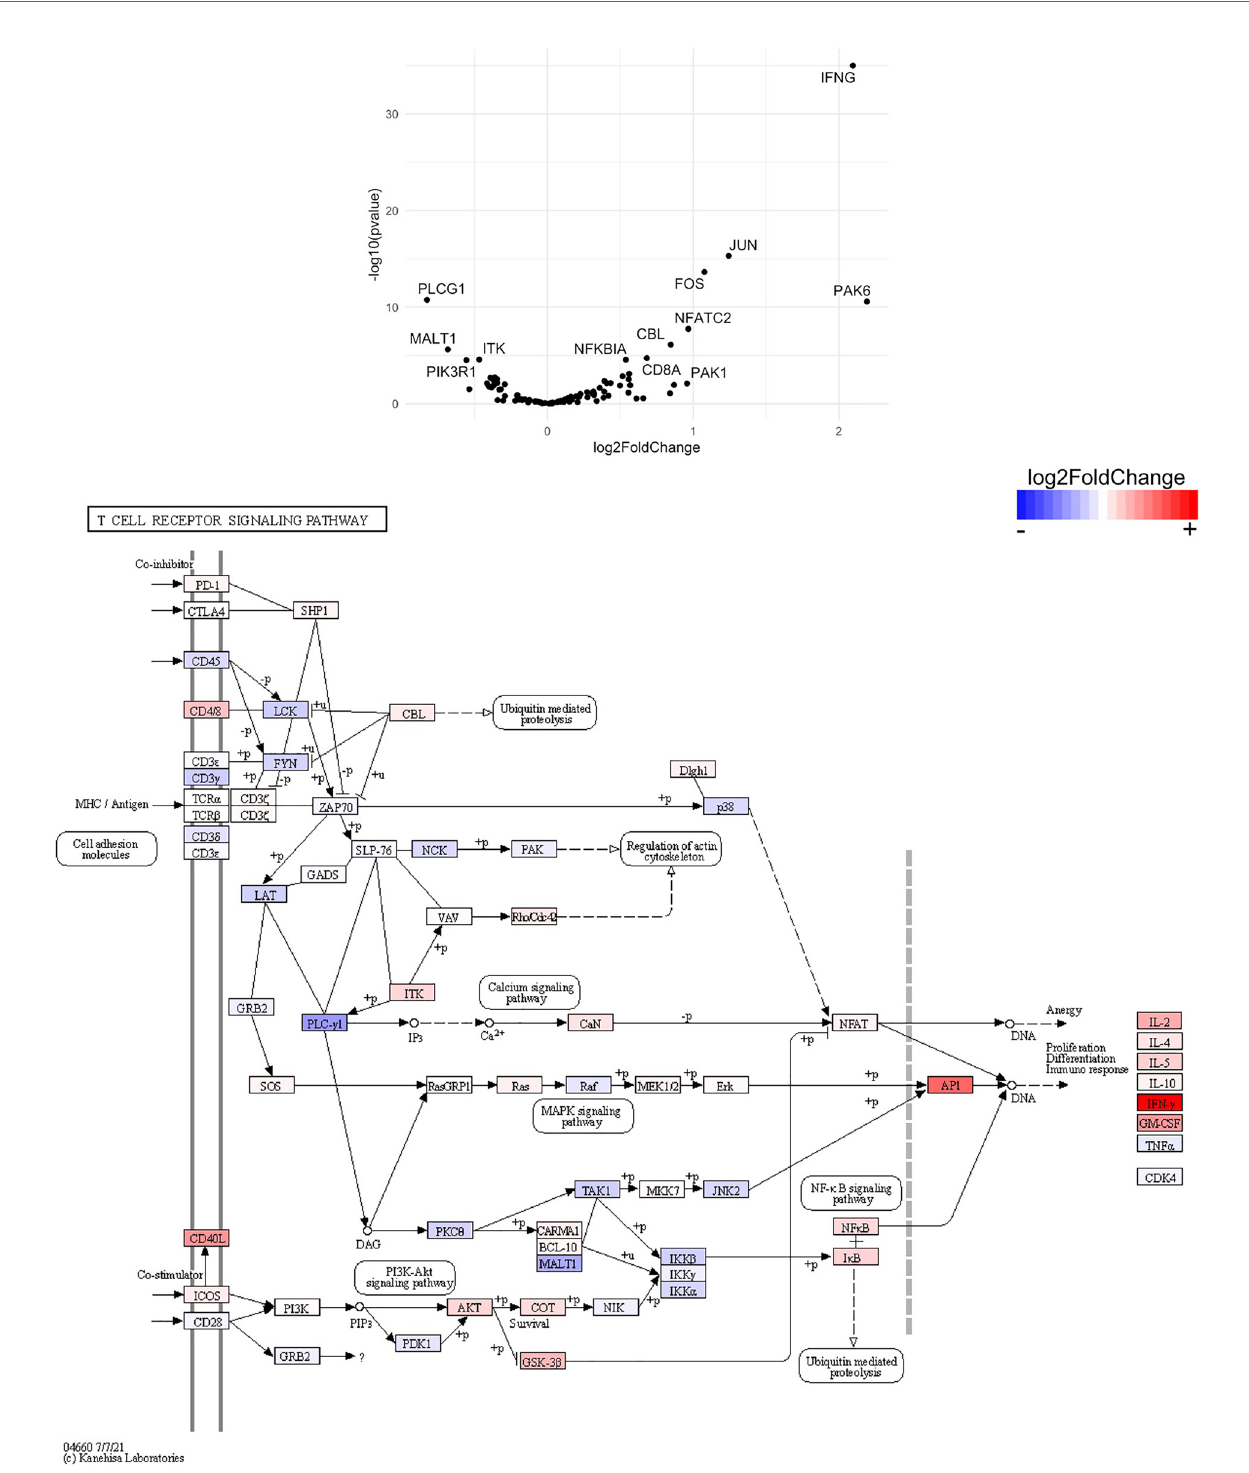
FIGURE 14 | Genes related to T cell receptor signaling are differentially expressed in CD4 + T cells from the CNS of microglia-de fi cient B6J mice compared to microglia-de fi cient SJL mice. C57BL/6J and SJL/J mice were treated with a PLX5622-supplemented diet seven days prior to i.c. TMEV infection and sacri fi ced at 6 DPI for analysis (n = 10 mice per group). Volcano plot of RNA-seq transcriptome data and KEGG map display T cell receptor signaling-related gene expression in enriched CD4 + T cells from the CNS of microglia-de fi cient C57BL/6J mice relative to microglia-de fi cient SJL/J